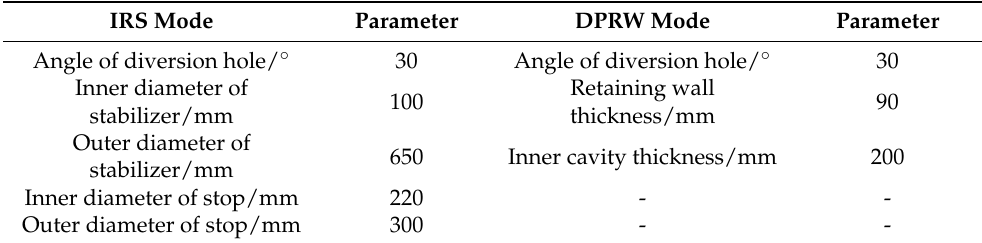
Figure 2. SCB mode structure chart. ( a ) IRS mode; ( b ) TIBO mode; ( c ) BITO mode; and ( d ) X mode. Table 1. SCB model structure parameters. Table 1. SCB model structure parameters.